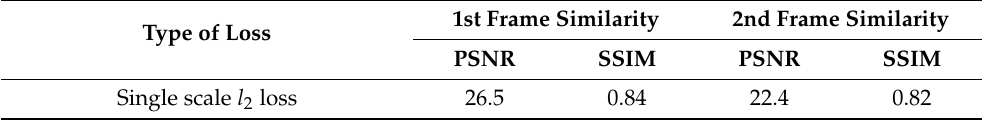
Table 4. Comparison results obtained after addition of different loss functions